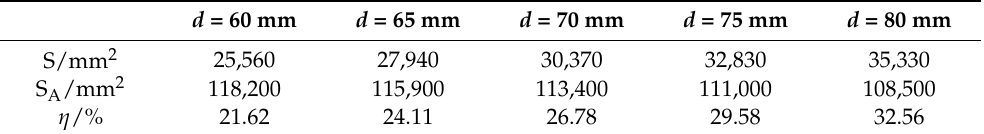
Table 3. Calculation results of ineffective operation area S, effective operation area S A and ineffective operation rate η